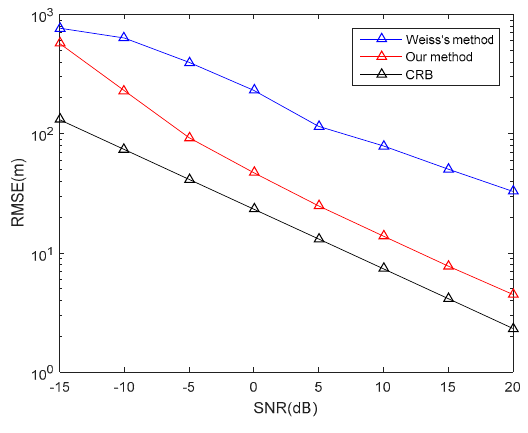
Figure 4. RMSEs versus SNR.